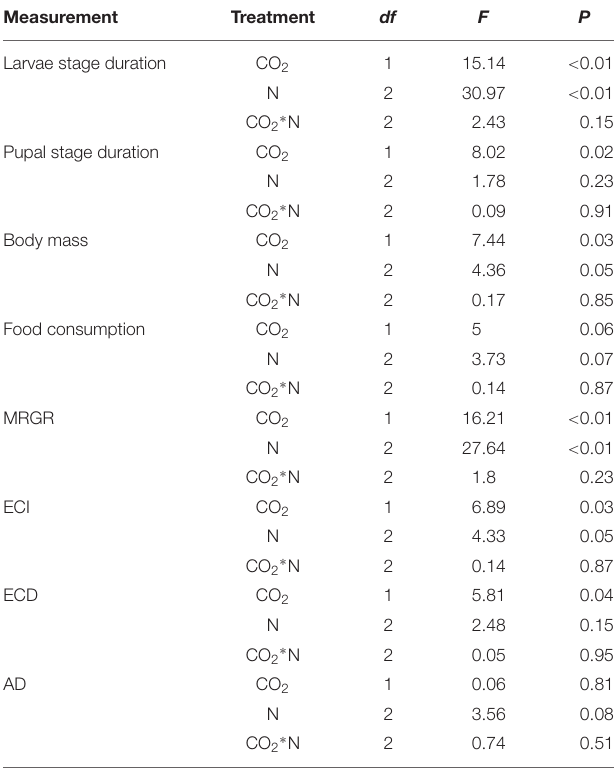
TABLE 6 | Summary of ANOVA results for effects of elevated CO 2 and increased nitrogen fertilization on development and digestibility of O. furnacalis .